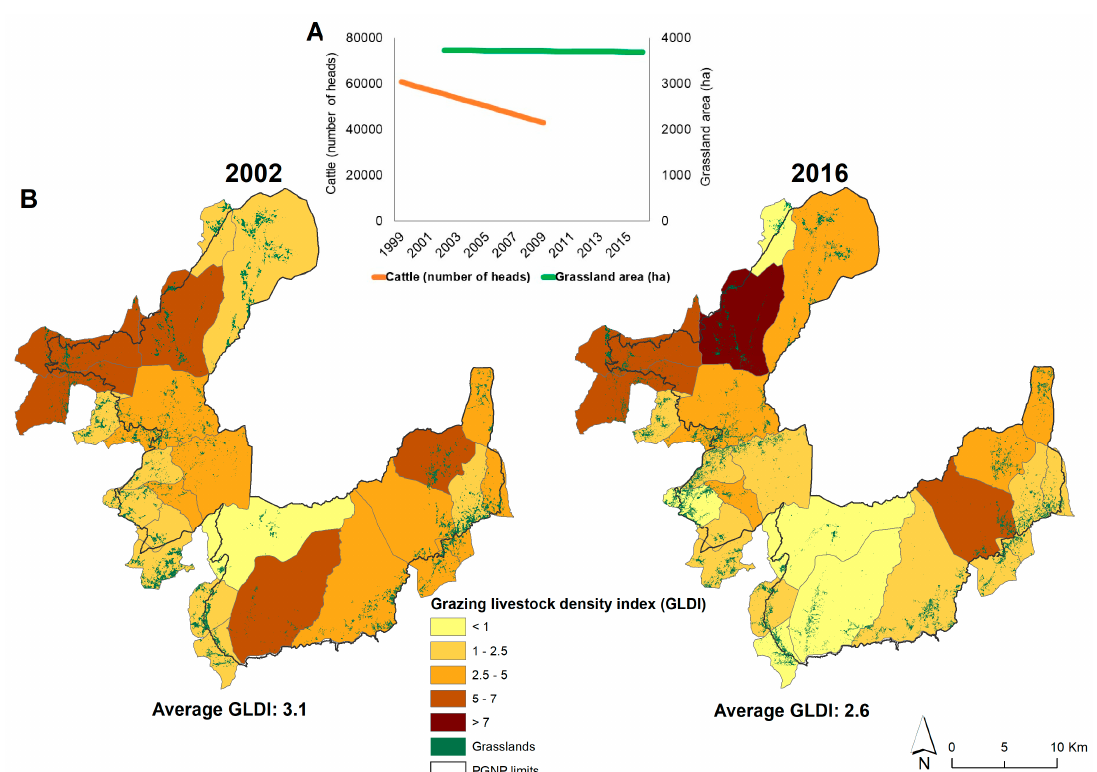
Figure 3. ( A ) Reared animals service provision demonstrated by the evolution in the number of cattle heads from 1999 to 2009 and the grassland area cover (ha) in 2002 and 2016 in the parishes of PGNP. ( B ) Grazing livestock density index (GLDI) in the parishes of PGNP, illustrating the level of cattle pressure in the grassland cover area in 2002 and 2016.